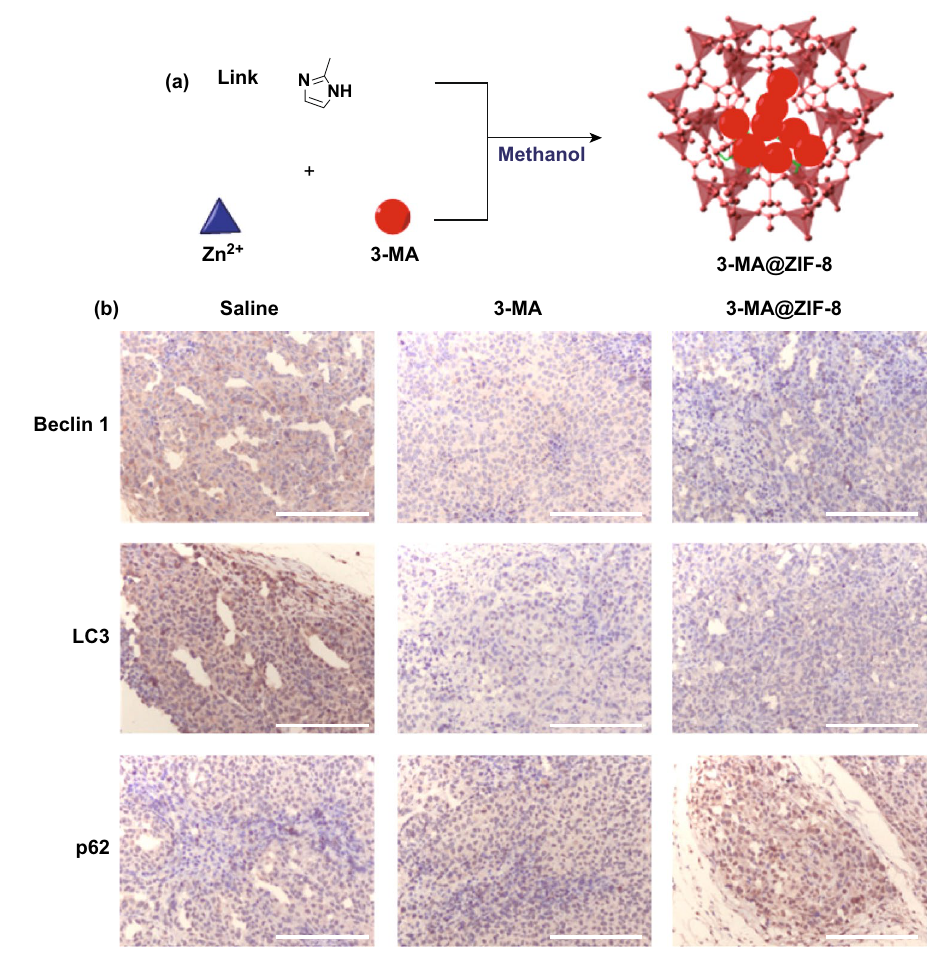
Fig. 5 a Encapsulation of autophagy inhibitor 3-MA into ZIF-8 nanoparticles. b Autophagic regulation proteins of xenograft tumor estimated by immunohistochemistry (scale bar: 200 μm). Reproduced with permission from Ref. [55]. Copyright 2017, American Chemical